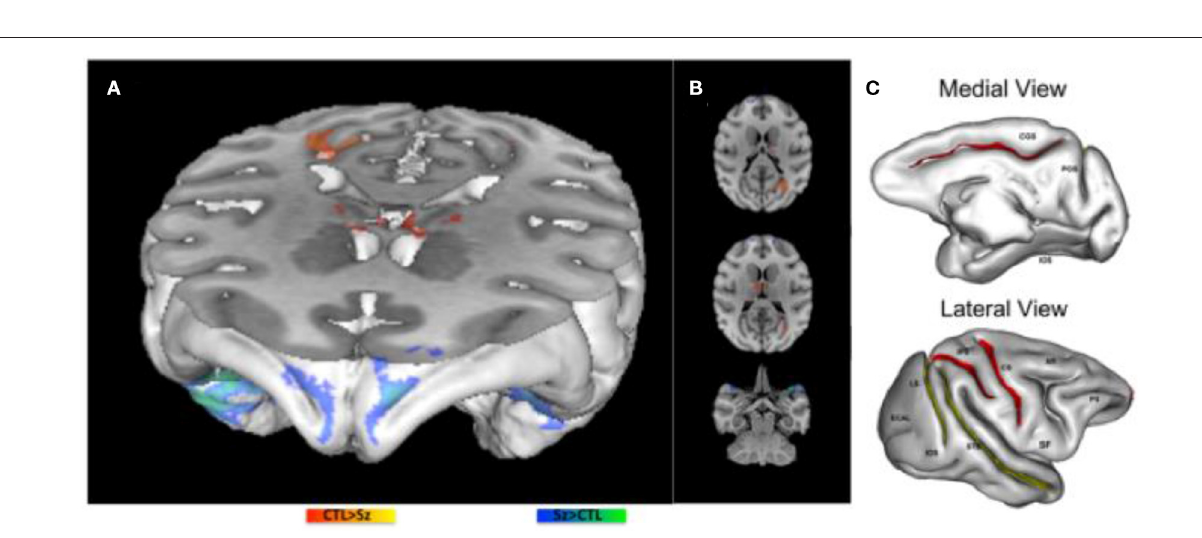
FIGURE 2 | Morphometric MRI Analyses in the Epileptic Baboon. (A,B) demonstrate increases (blue) and decreases (red) in gray matter concentration in epileptic baboons compared to controls. (C) Demonstrate significant decreases (red) and marginally significant decreases (yellow) in sulcal areas of baboons with IEDs on scalp EEG compared to healthy controls [adapted from Epilepsy Research , references ( 35, 38),